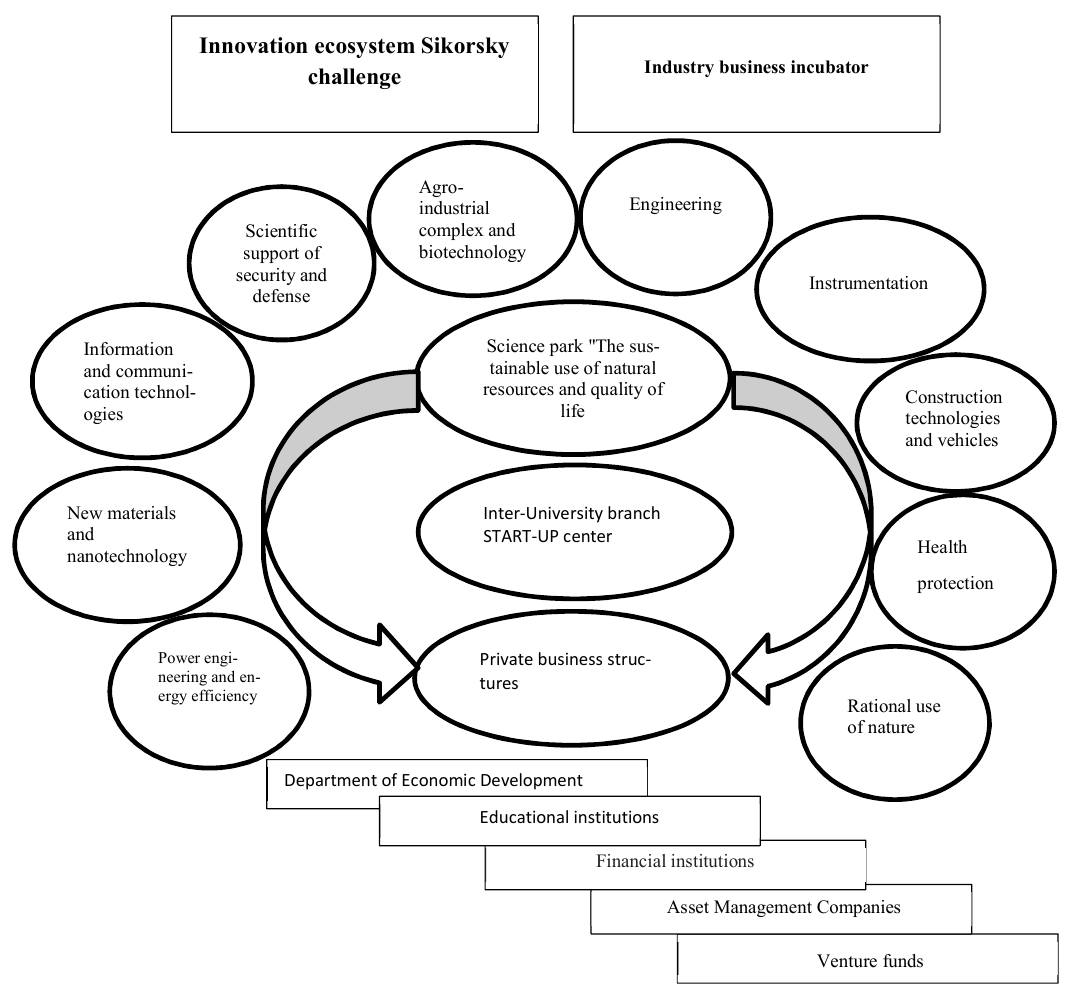
Fig. 1. Innovation educational and production cluster of public-private